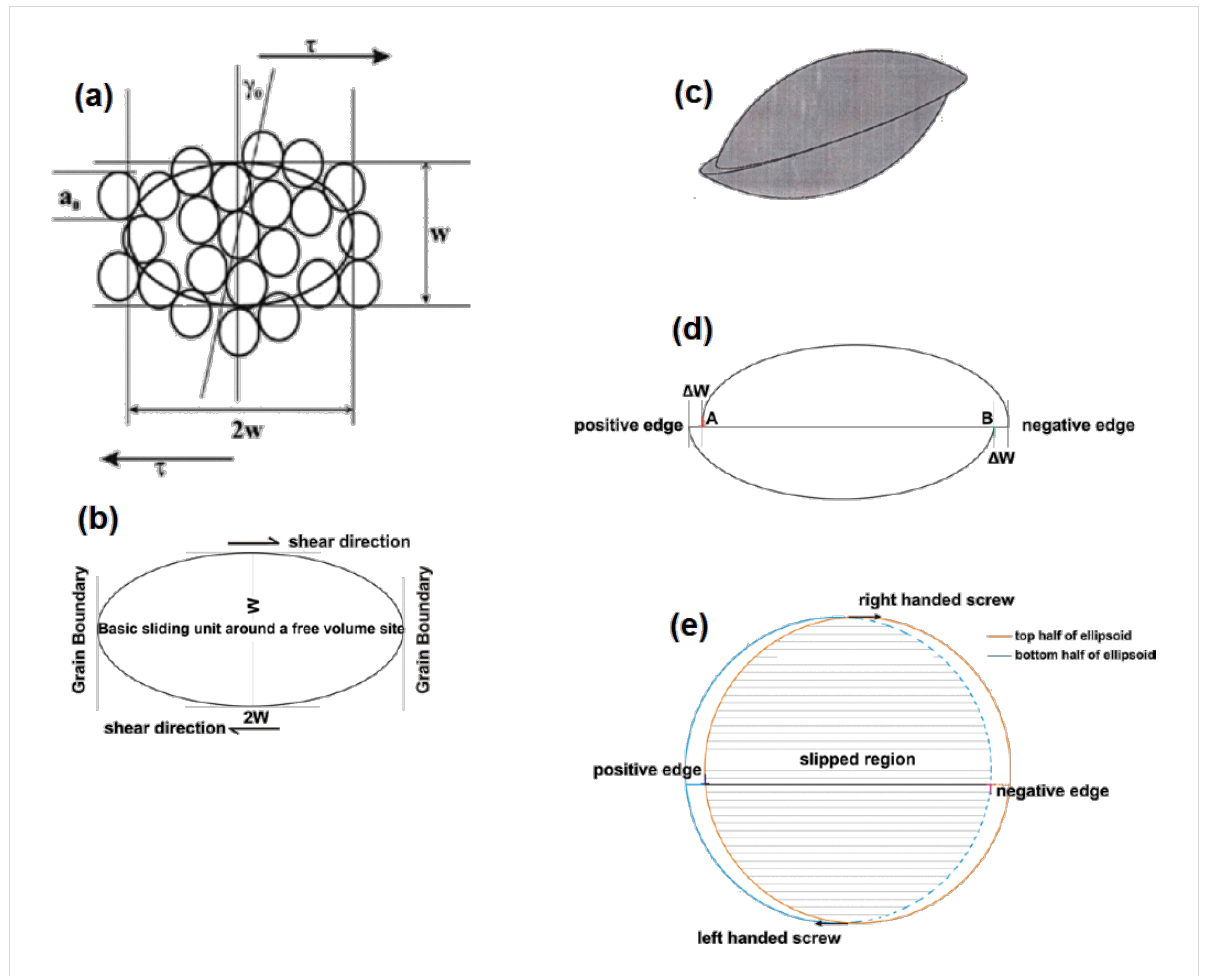
Figure 4: (a) Sliding/Shear unit, according to the GBS Model. (b) Elevation view of the undeformed oblate spheroid. (c) Isometric view of the deformed oblate spheroid. (d) Elevation view of the deformed oblate spheroid. (e) Plan view of the deformed oblate spheroid. Reproduced with permission from [27]. Copyright 2012